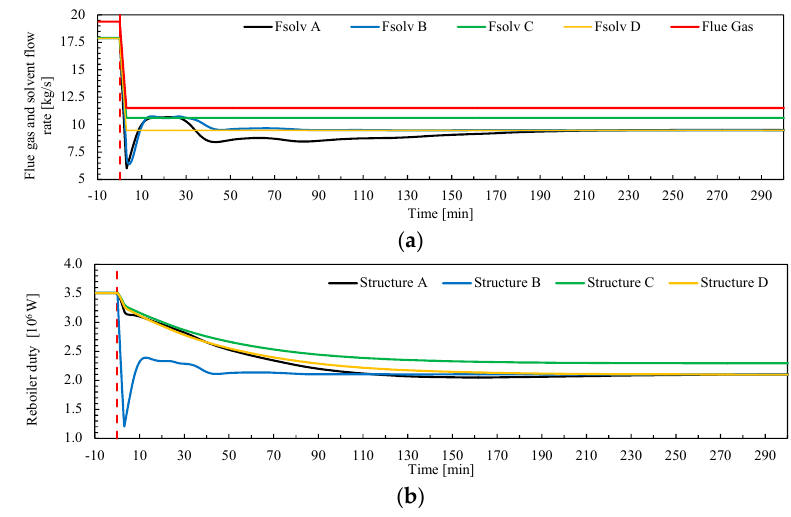
Figure 9. Inputs to the pilot plant during simulations for load change ramp-down (Test 1) from 100 to 70% with a ramp rate of 10%/min reduction in flue gas flow rate, for control structures A, B, C and D. ( a ) Flue gas flow rate (kg/s), as a disturbance, and solvent flow rates (kg/s) of the rich pump as manipulated variables (MVs); ( b ) Reboiler duty (W) as MV. The red vertical dotted line shows when the transient event starts at t 0 .